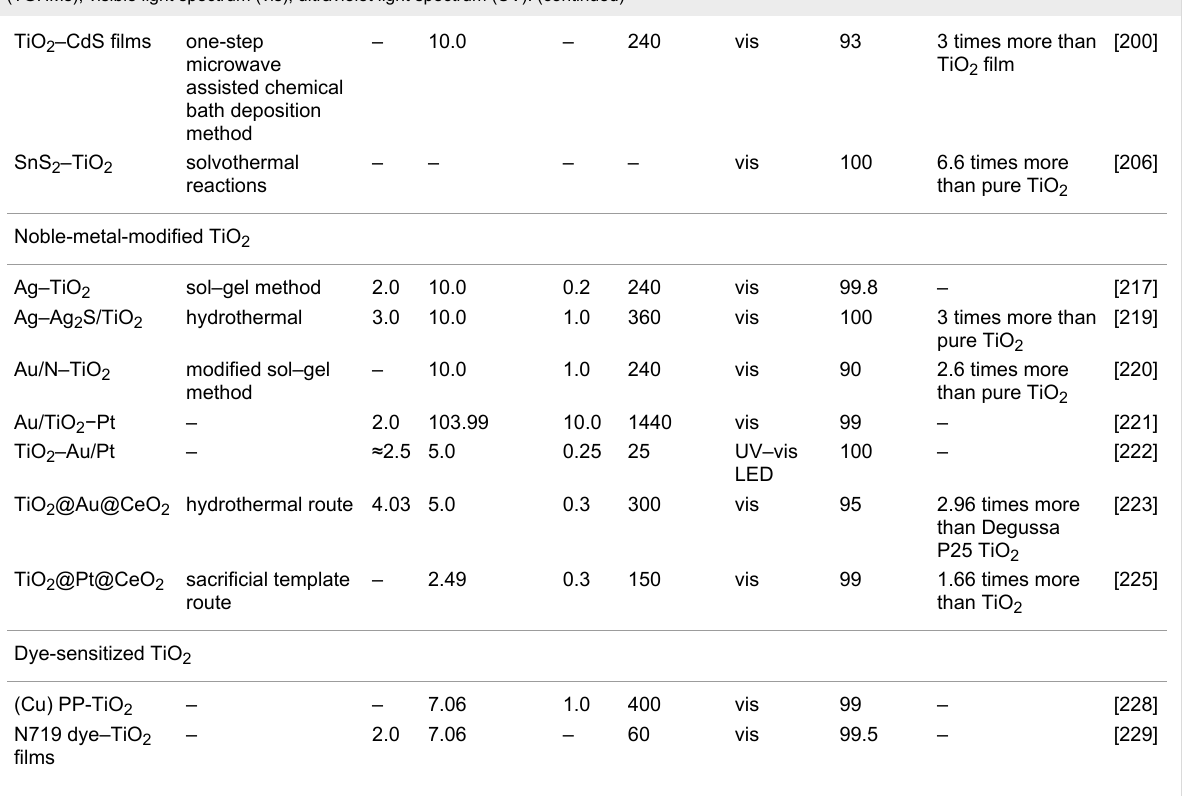
Table 1: Preparation methods of modified photocatalysts, experimental conditions for photocatalytic reduction of Cr(VI), source of illumination, per- centage of Cr(VI) reduction and comparison of the composite modified-photocatalyst performance with TiO 2 . Reduced graphene oxide (RGO), car- bon nanotubes (CNTs), carbon dots (CDs), nanorod arrays (NRAs), reduced graphene oxide hydrogel (rGH), TiO 2 hollow-core–shell microspheres (TGHMs), visible light spectrum (vis), ultraviolet light spectrum (UV).